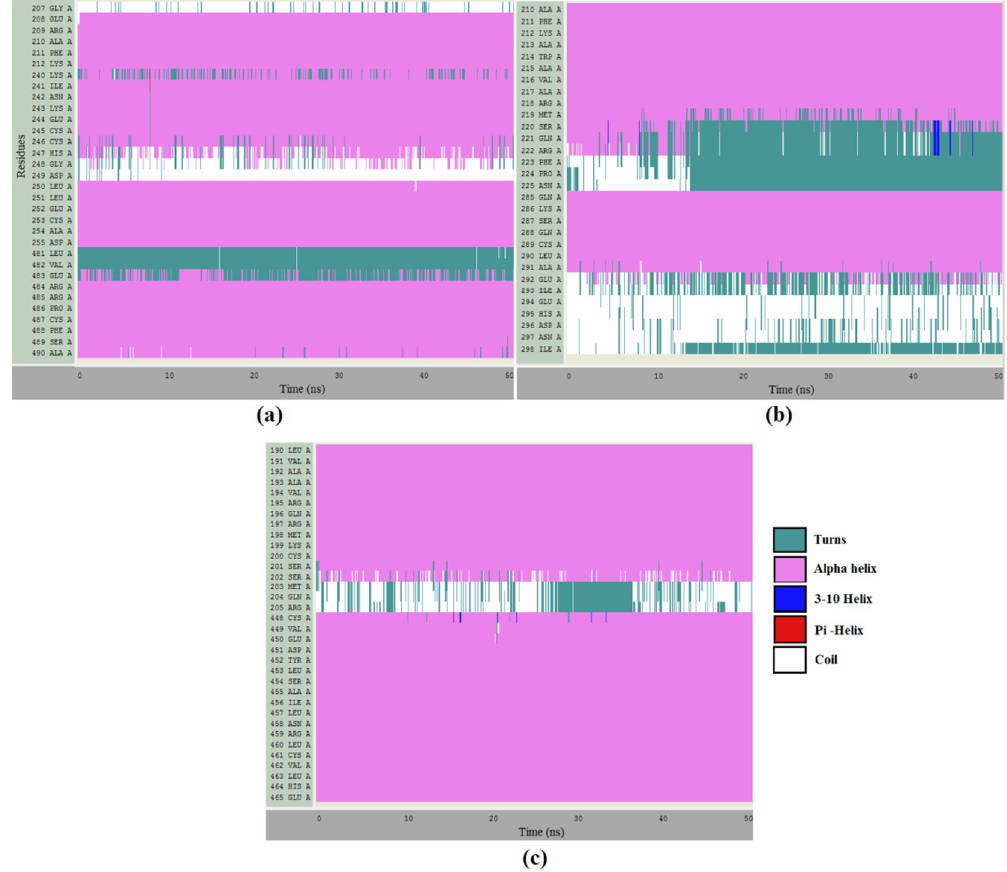
Figure 11. Molecular dynamic simulation along 50 ns of site 1 ( a ), site 2 ( b ), and site 3 ( c ), showing the smooth running of the α-helix content.